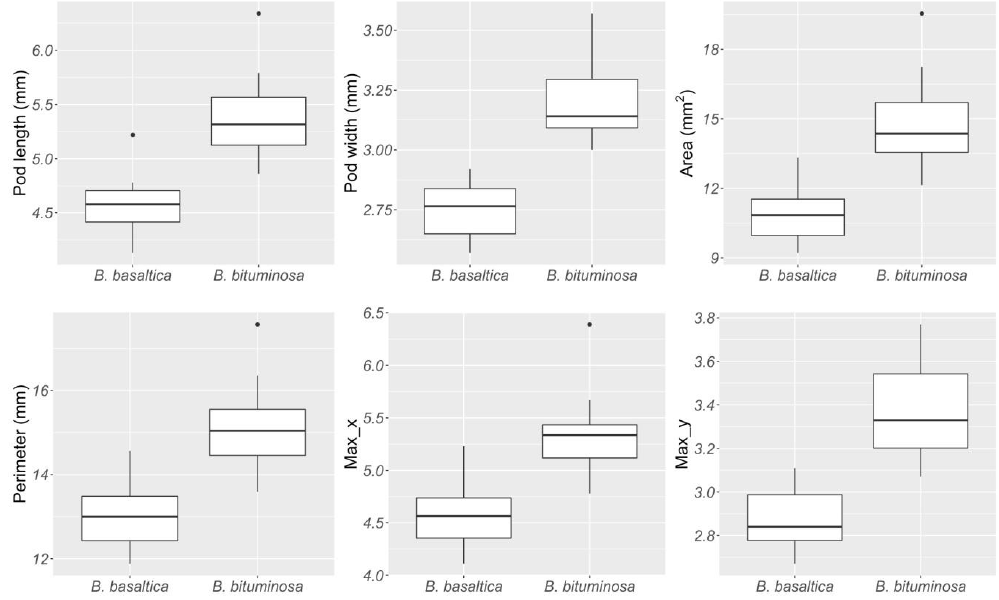
Figure 1. Box plot showing the mean average values of different pod morphometric traits in B. basaltica and B. bituminosa . Max X = major axis of the ellipse; Max Y = minor axis of the ellipse.